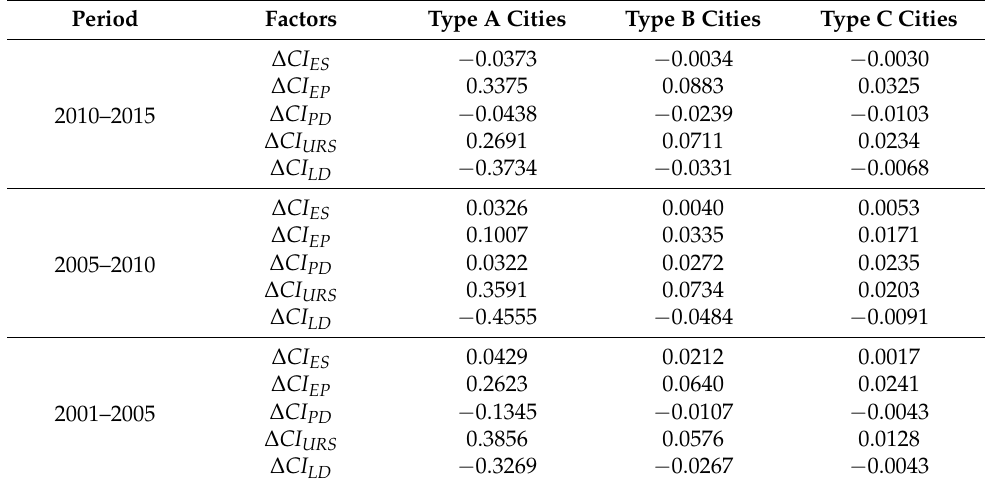
Table 4. Results of the decomposition analysis of carbon intensity for different types of cities (tCO 2 /(10 4 yuan)).